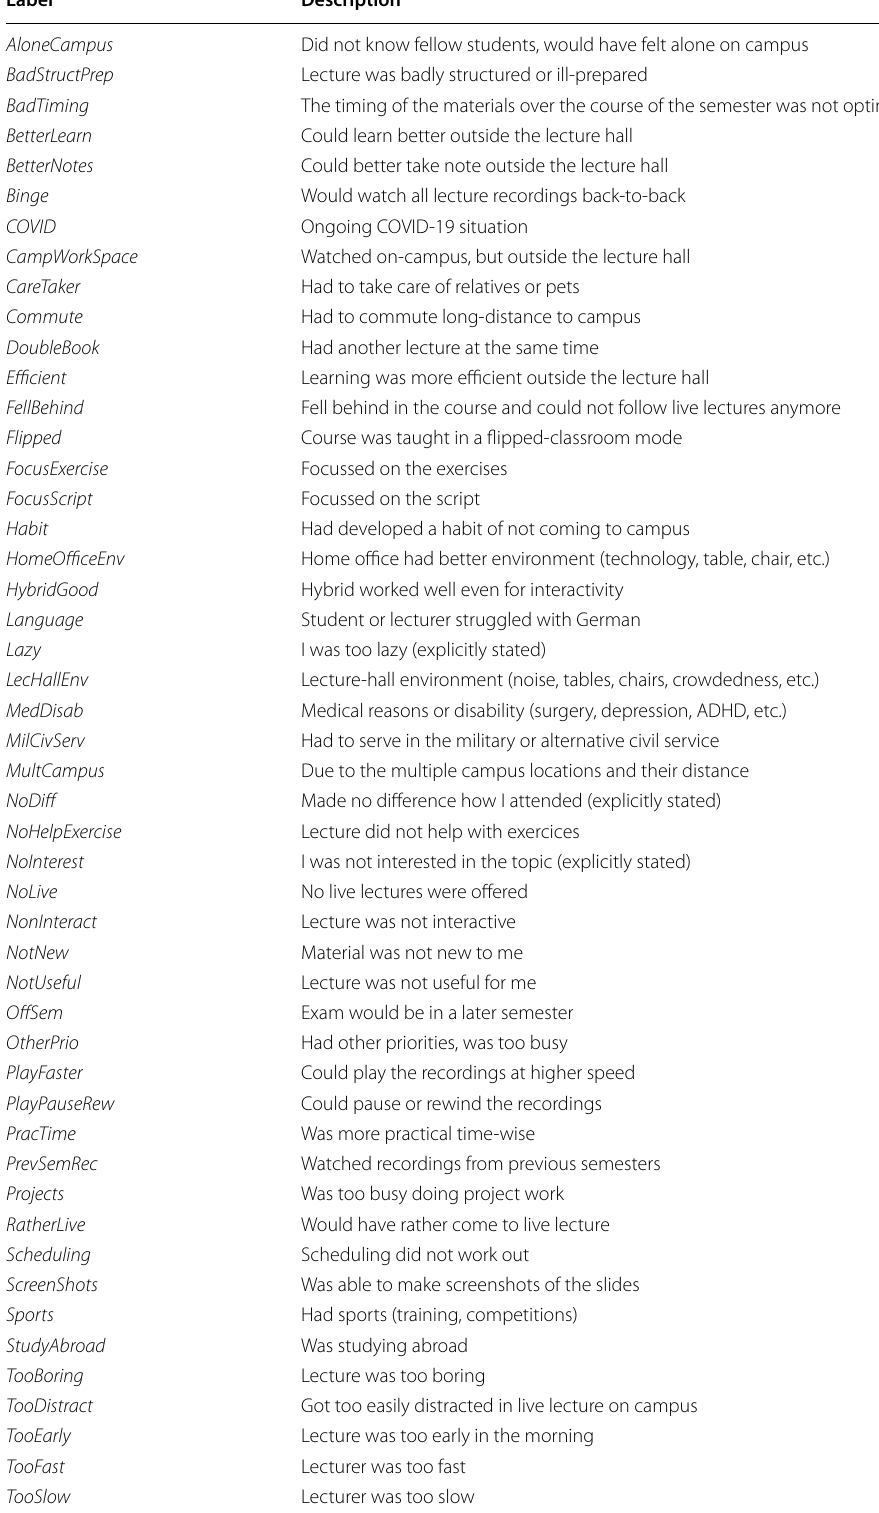
Table 4 Categories of responses to items NotLiveCampReason , RecOnlyWhy , and RecOnlyReason